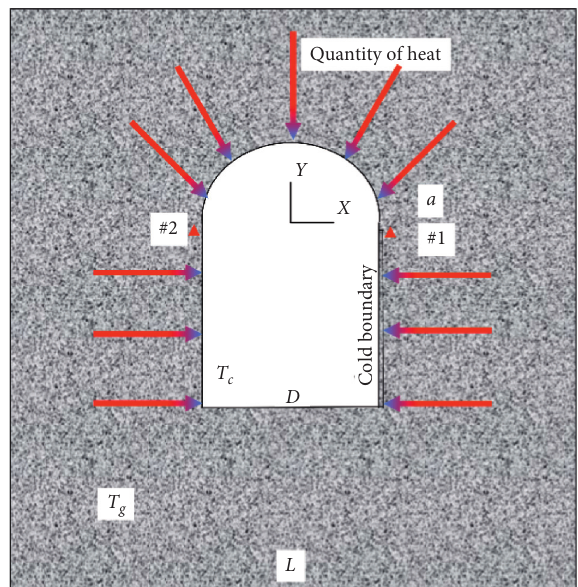
Figure 1: Model of the underground circular arch